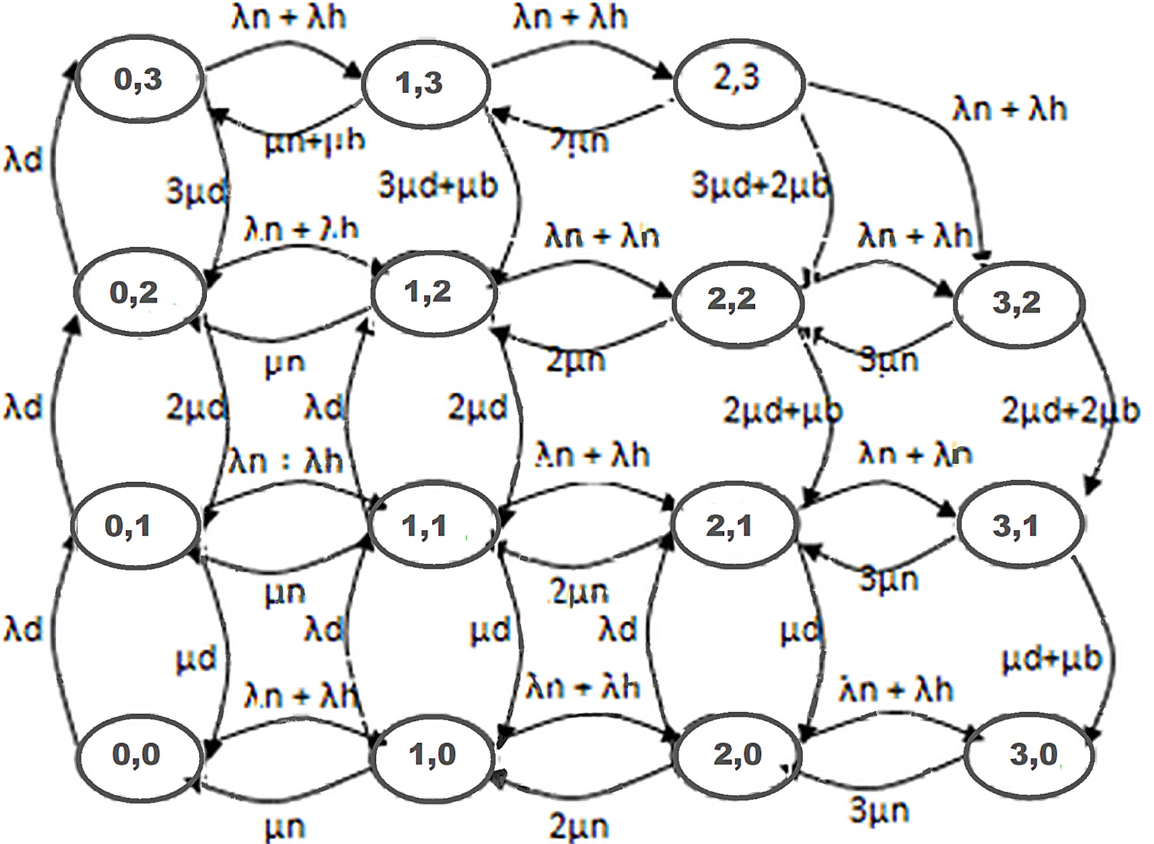
Figure 2. Two ‐ dimensional Markov chain for mixed traffic services with packet queue. Figure 2. Two-dimensional Markov chain for mixed traffic services with packet